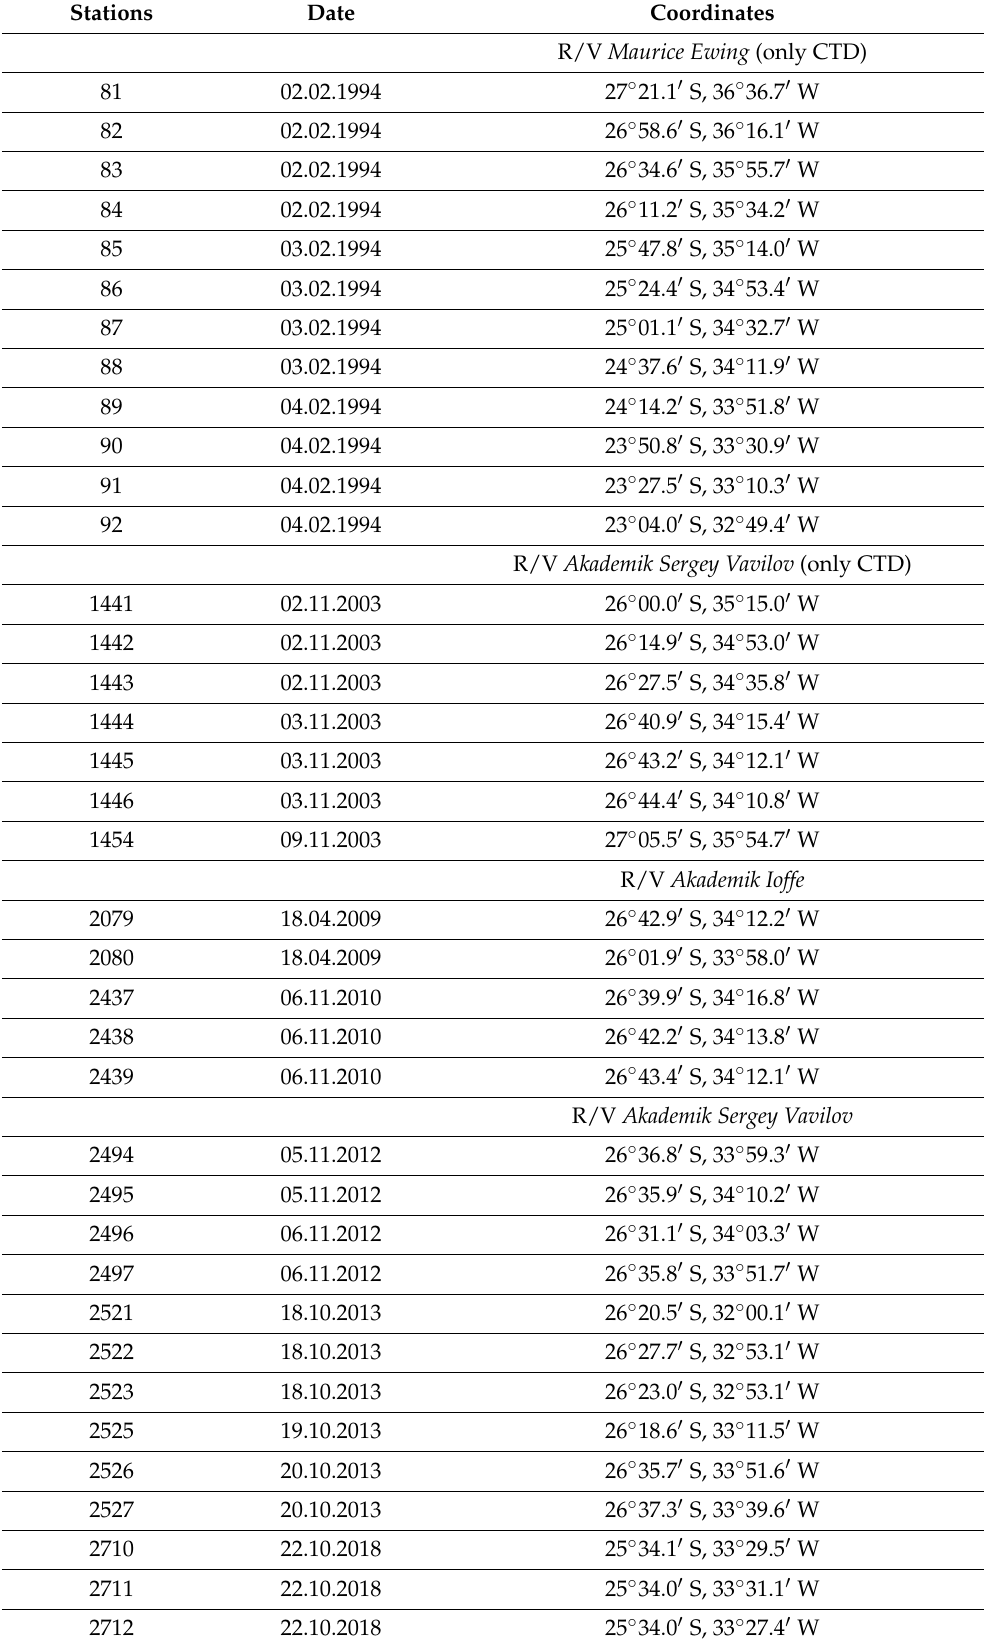
Table 1. CTD/LADCP stations at the exit from the Vema Channel in